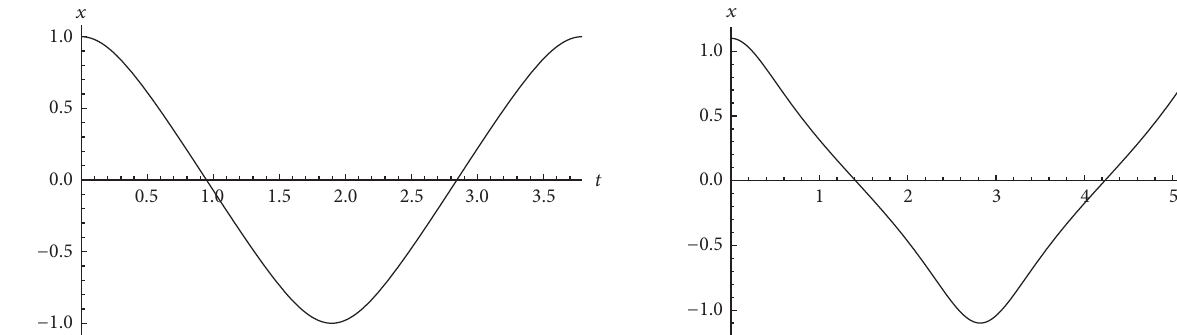
Figure 5: Exact solution 𝑥 in (40) as a function of time t when 𝑎 1 = = 3 , and 𝑥 = 1.1 −1 , 𝑎 5 0